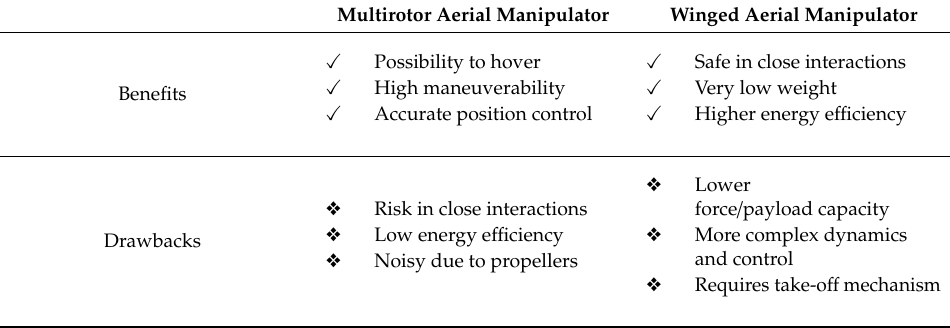
Table 2. Benefits and drawbacks of multirotor-based and winged aerial